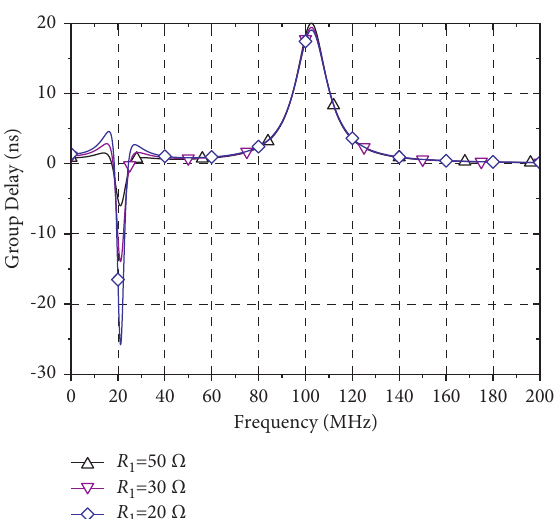
Figure 12: Negative delay of band pass in the band-stop filter with different R